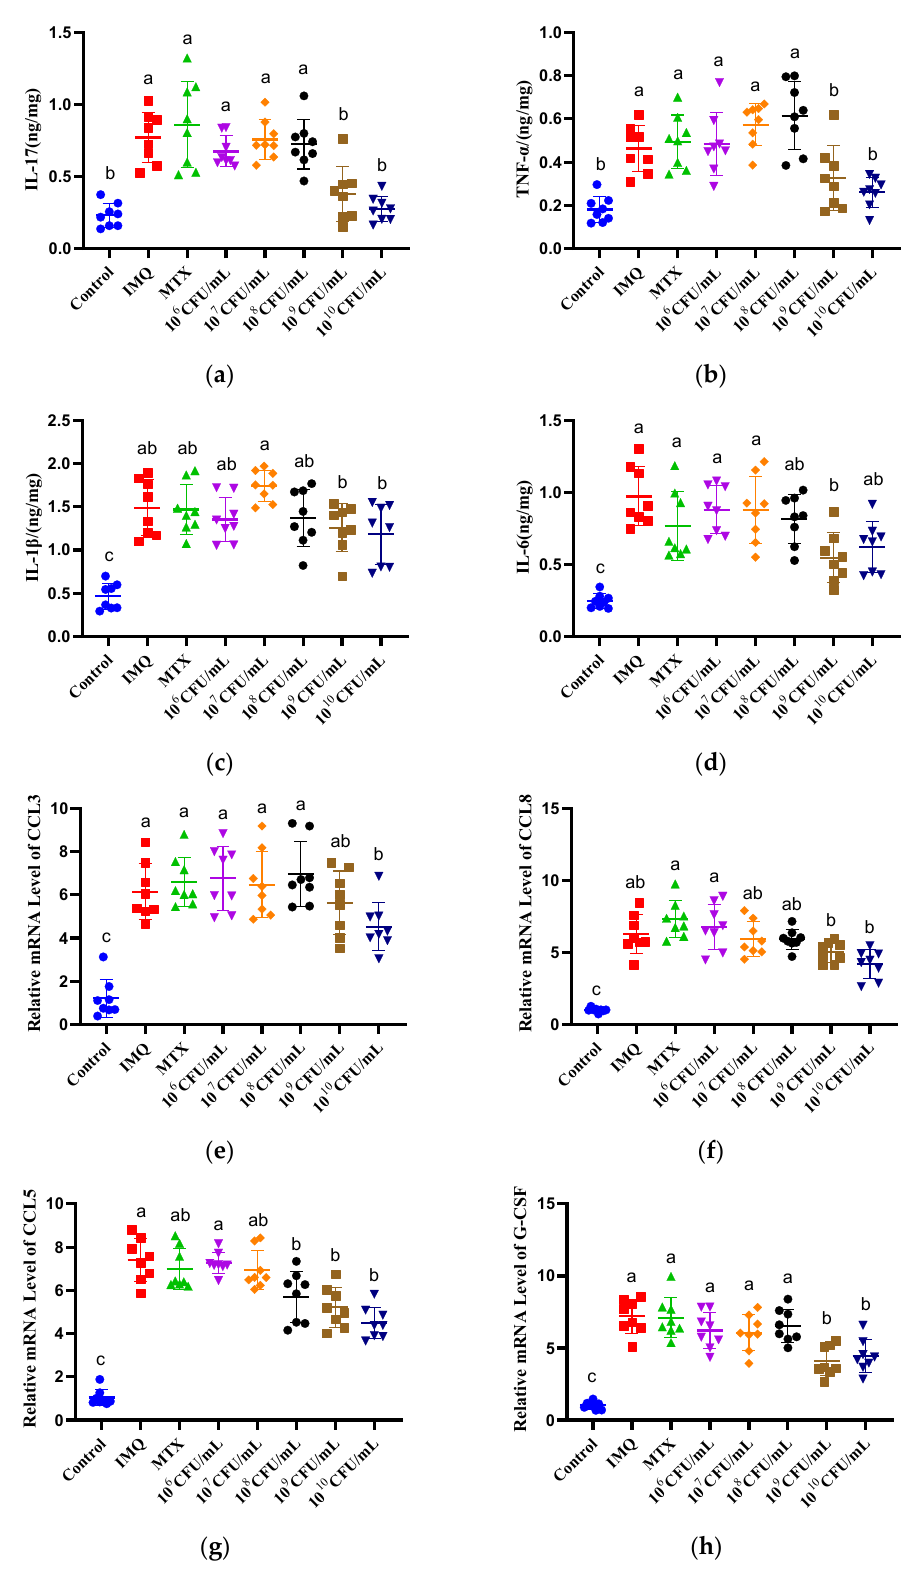
Figure 8. Effect of CCFM683 treatment on inflammatory responses in psoriasis mice. The concentration of ( a ) IL-17, ( b ) TNF- α , ( c ) IL-1 β , and ( d ) IL-6 and the mRNA levels of ( e ) CCL3, ( f ) CCL8, ( g ) CCL5, and ( h ) G-CSF. n = 8 mice per group. Groups with different letters are significantly ( p < 0.05) different from each other.